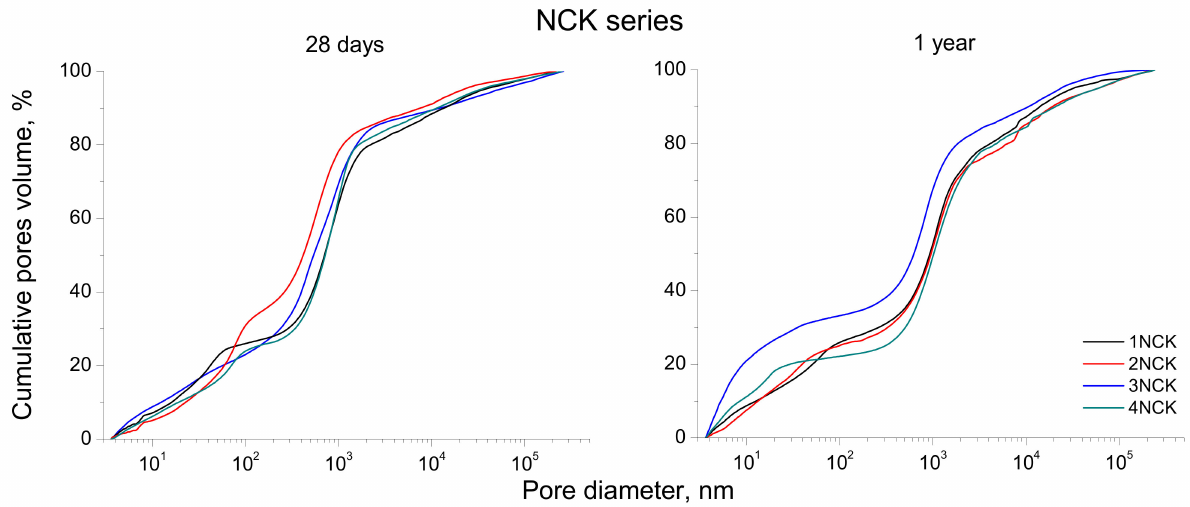
Figure 4. Cumulative volumes of pores in percentage versus pore size curves for mortars with natural